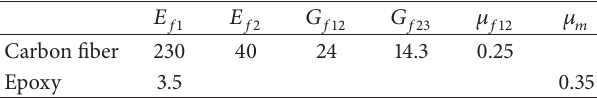
Table 1: Materials properties of components